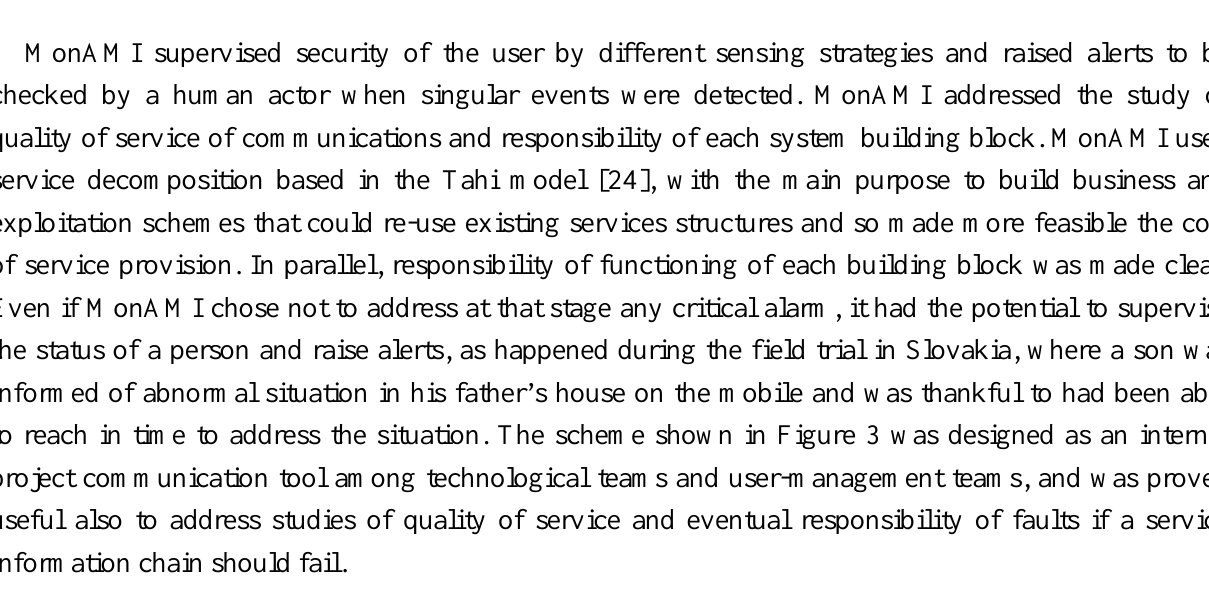
Figure 3. Service communications mapped on technology blocks allowed for inter-team understanding and Quality of Service and responsibility of faults assessment. Tele-monitoring and monitoring